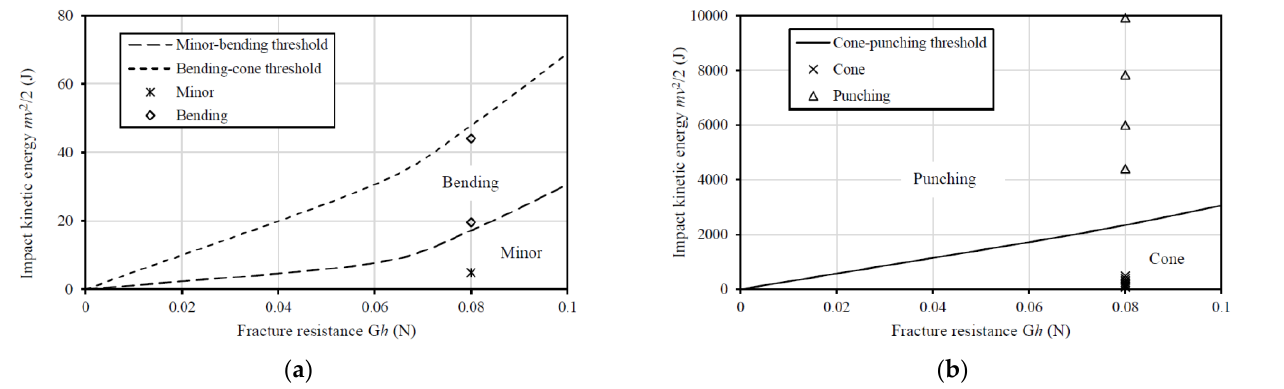
Figure 15. Breakage regimes and the mapping of failure points: ( a ) minor and bending damage; ( b ) cone and punching failure.